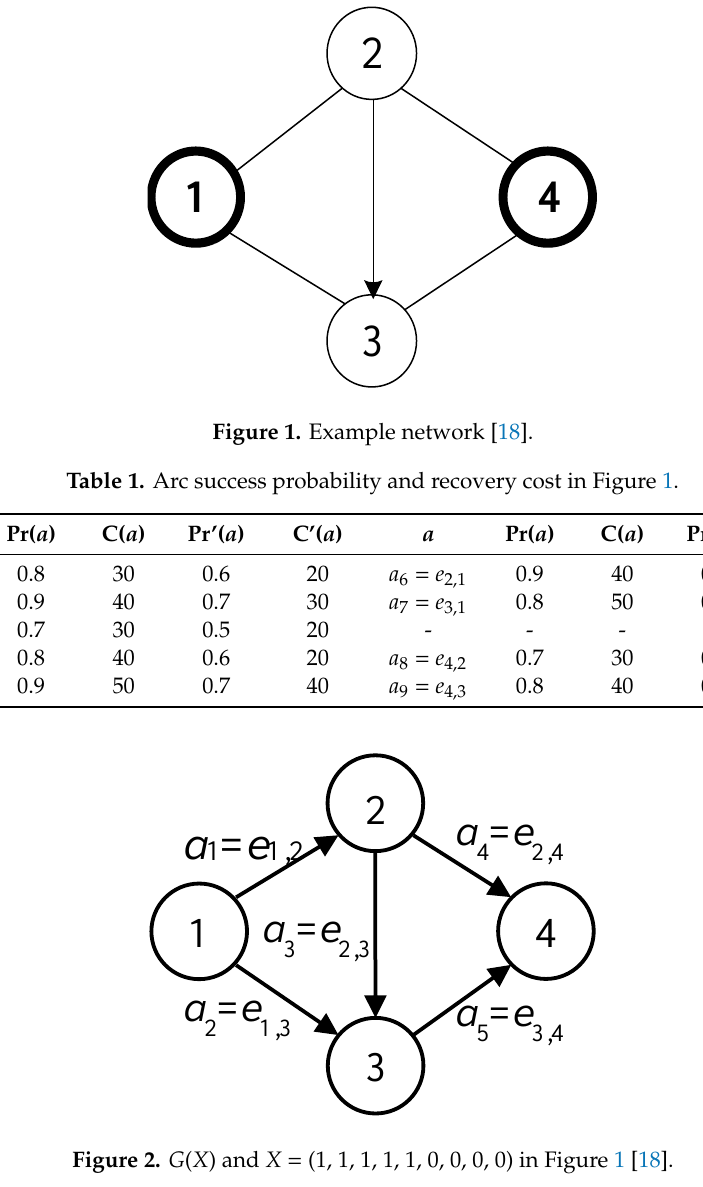
Figure 2. G ( X ) and X = (1, 1, 1, 1, 1, 0, 0, 0, 0) in Figure 1 [18].